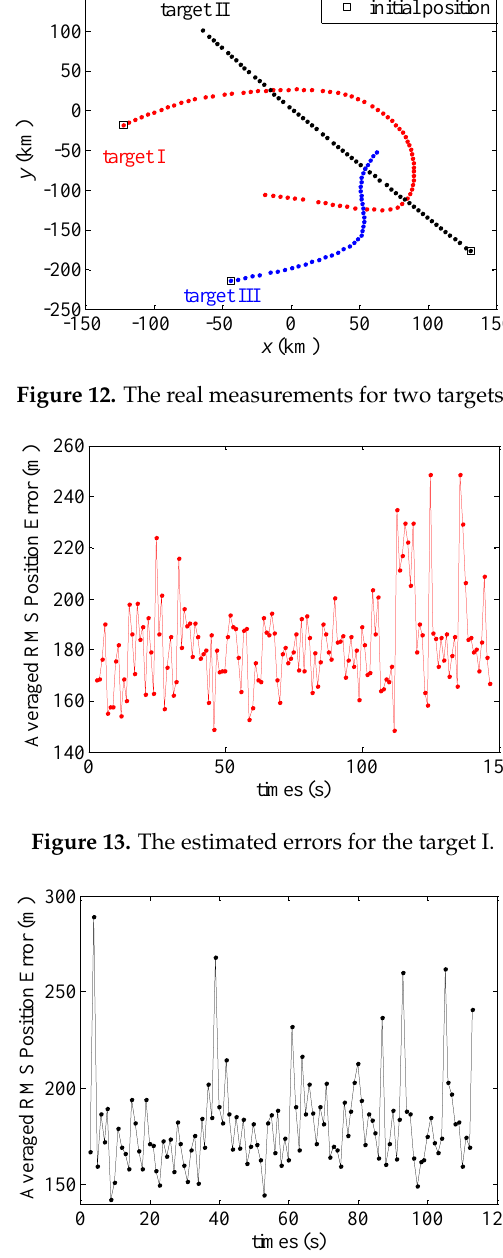
Figure 15. The estimated error for the target III. 6. Conclusions This paper presented an improved joint probabilistic data association-fuzzy recursive least squares filter (IJPDA-FRLSF) for multiple maneuvering target tracking (MMTT) in situations with unknown measurement noise covariances and unknown target dynamic models. In the proposed filter, two uncertain models of measurements and observed angles were established, and their related parameters were analyzed in temporal and spatial sense. Using these two uncertain models, an additive fusion strategy was constructed to calculate the generalized joint association probabilities of measurements belonging to different targets, which were utilized to replace the joint association probabilities of the standard joint probabilistic data association (JPDA) algorithm. The FRLSF method was utilized to update all tracks. The proposed filter can relax the restrictive assumptions of measurement noise covariances and target dynamic models. It benefits from FRLSF by not requiring